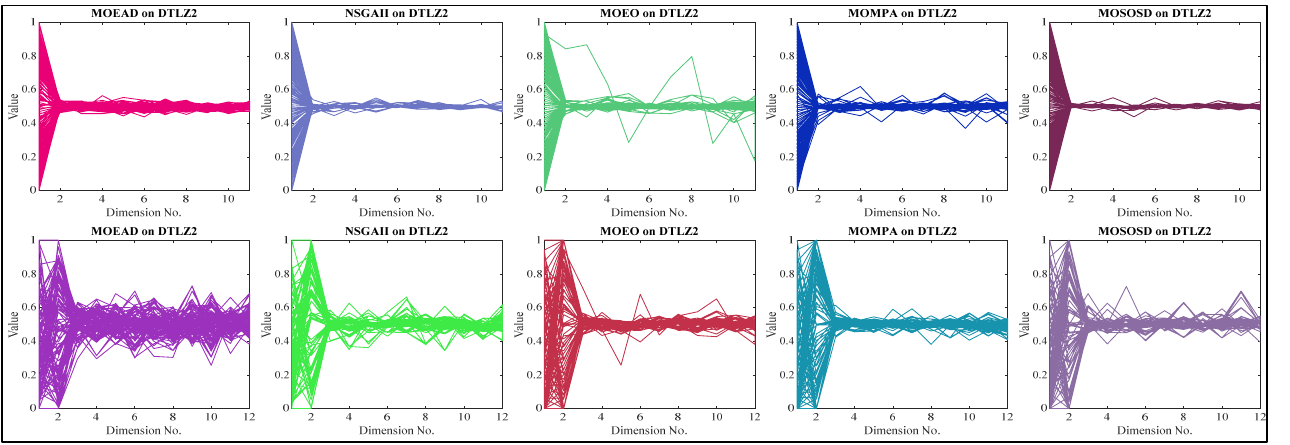
Figure 10. The dimension curve of MOEA/D, NSGA-II, MOEO, MOMPA, and MOSOS/D for DTLZ2 at 𝑀 = 2, 3 .